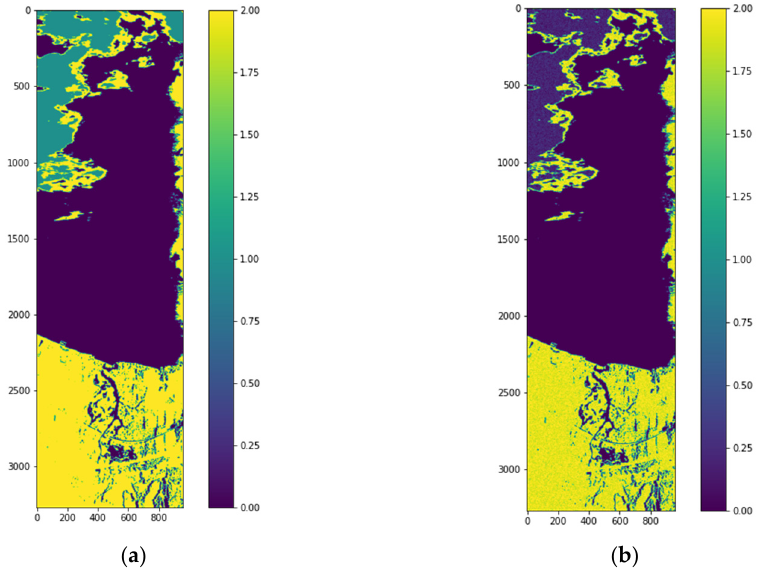
Figure 9. ( a ) HSI2 Image 1 with labels for 3 classes using the unsupervised stage (k-means clustering method), ( b ) Reconstructed image from classified samples using the supervised stage.